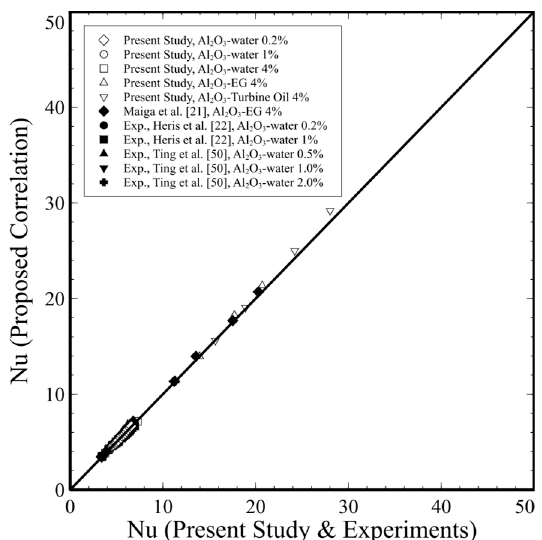
Figure 11. Proposed correlation vs computed results and experiments of Nu in a straight tube.